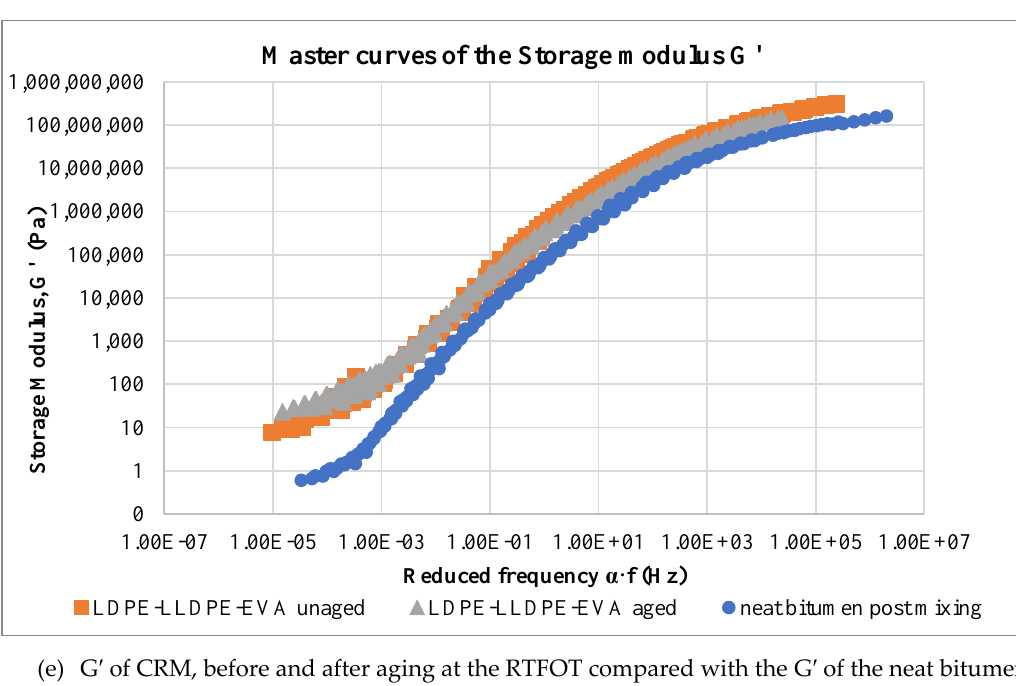
Figure4. MastercurvesofG (cid:48) at30 ◦ Figure 4. Master curves of G′ at 30°C for each polymer-modified bitumen (PMB) at aged and unaged conditions.